Question: State the chart type depicted above.
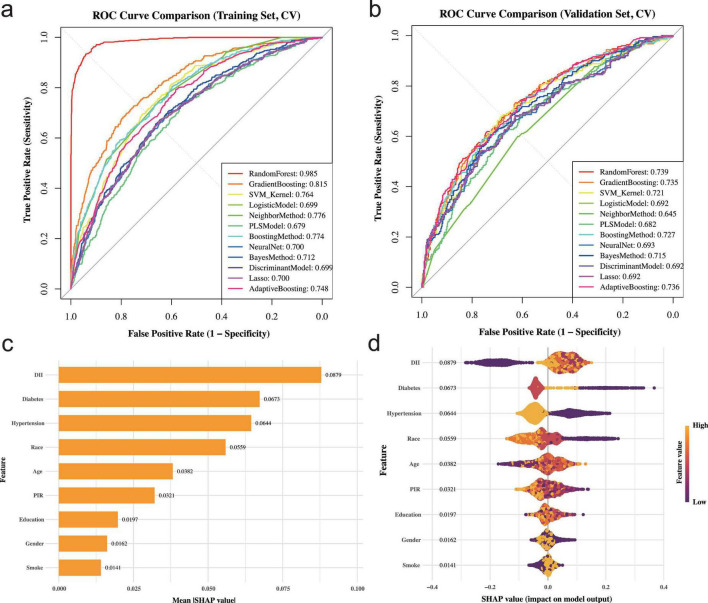
Answer: line